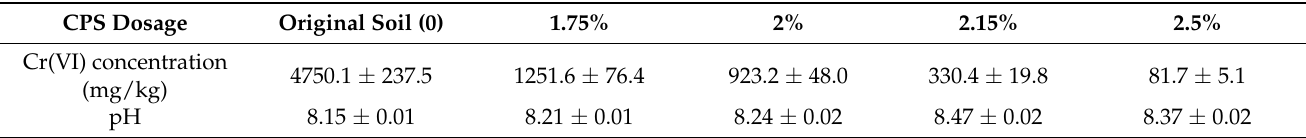
Table 3. Cr(VI) concentration and pH under different CPS